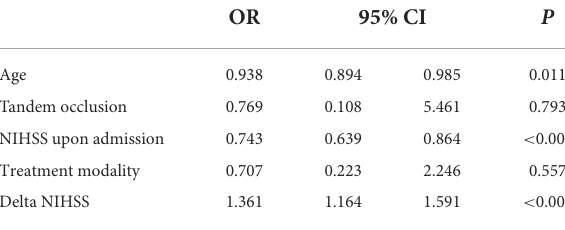
TABLE 3 Multivariate analysis for favorable